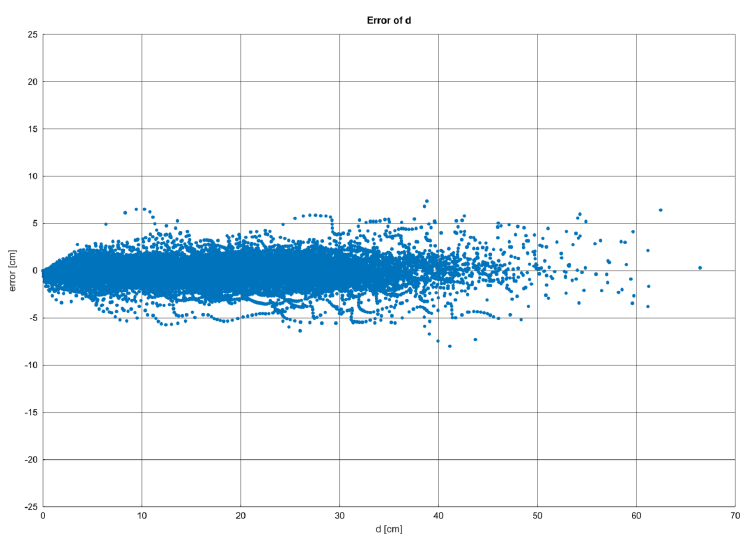
Figure 4. Residuals versus fitted values for the REG model for